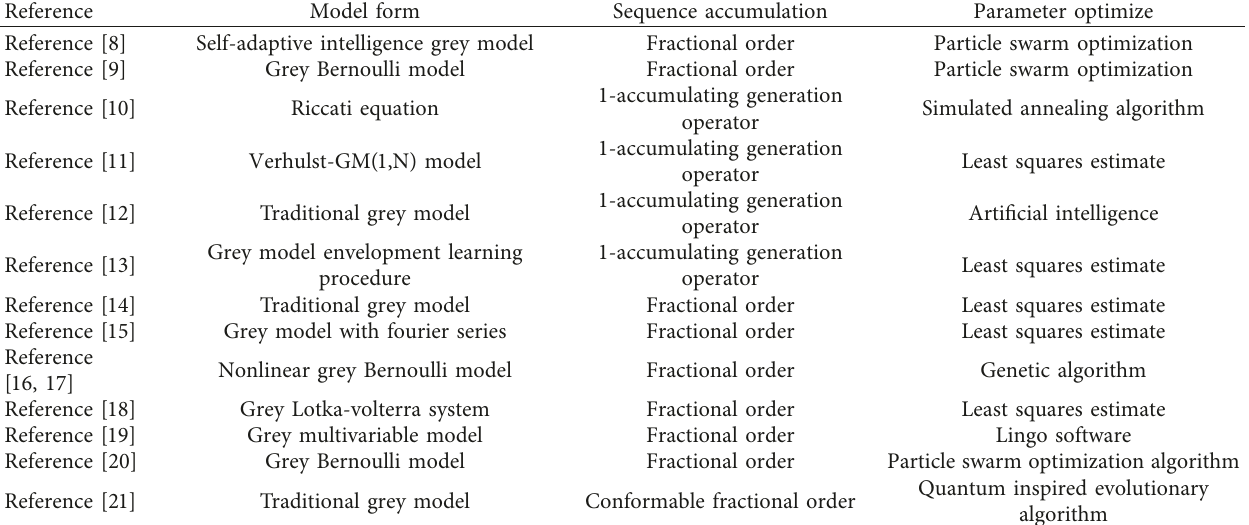
Table 1: The review of previous studies.